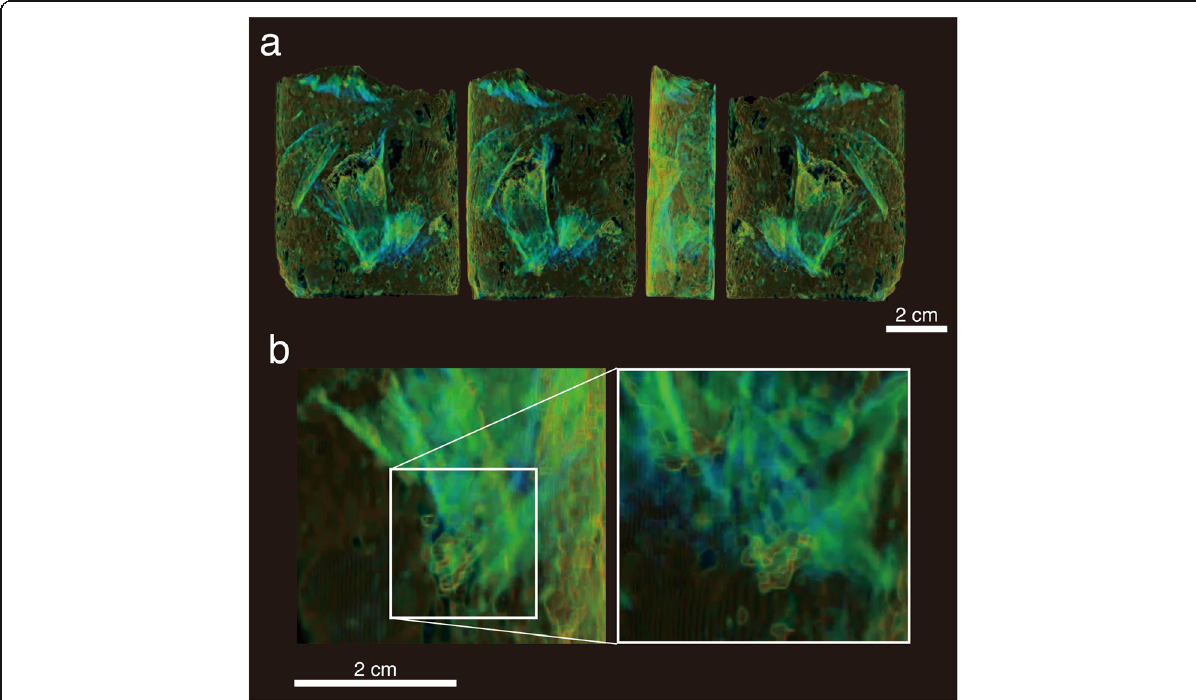
Fig. 6 X-ray CT images processed with a volume-rendering technique. a Volume-rendering-processed images of rudist B in the studied core. The images are shown in clockwise rotation from the external core surface (left) to the split core surface (right). b Enlarged images of the spat of rudist B